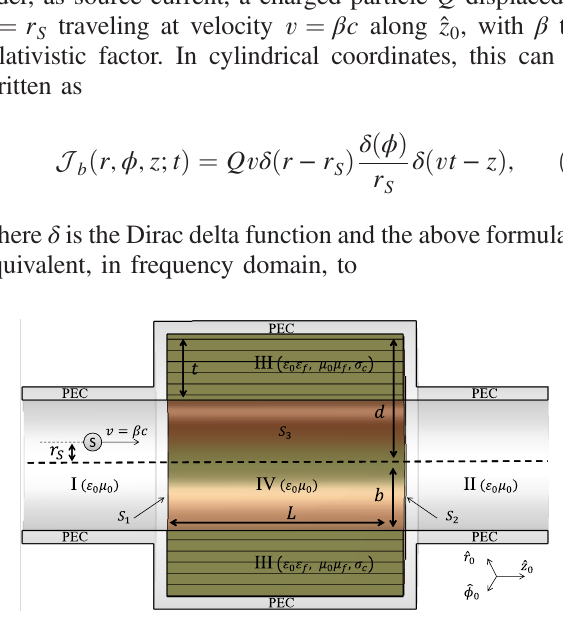
FIG. 1. Structure under study: loaded cavity connected with two beam